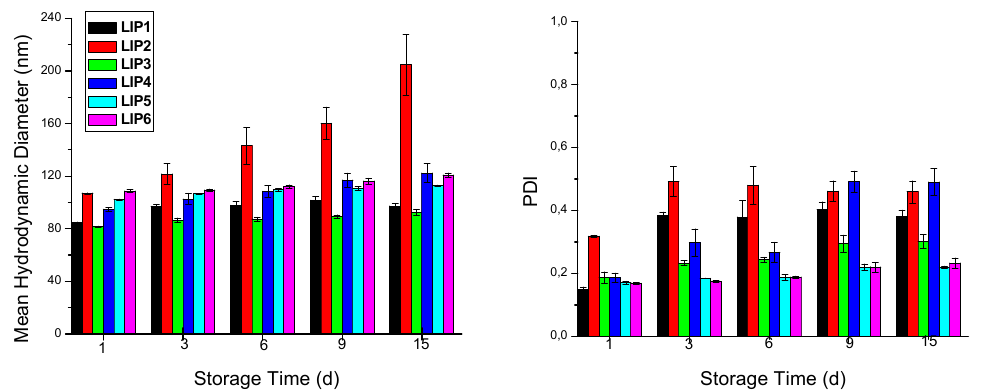
Figure 5. Size (d-hydrodynamic mean diameter, nm) and pdi values of the LIP1–LIP6 prepared dispersions, in PBS buffer 7.4 at a lipid concentration of 5mg/mL, during storage at 4 °C. Each value is the mean of at least 5 different measurements and bars are the SD values of each mean.